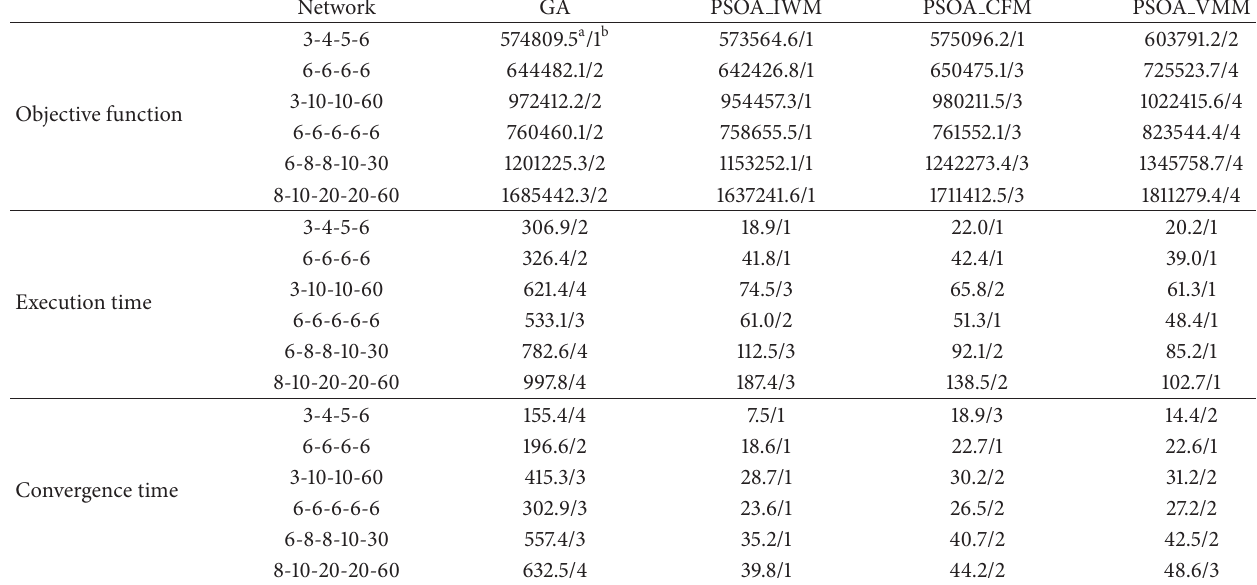
Table 12: Analysis results on different network